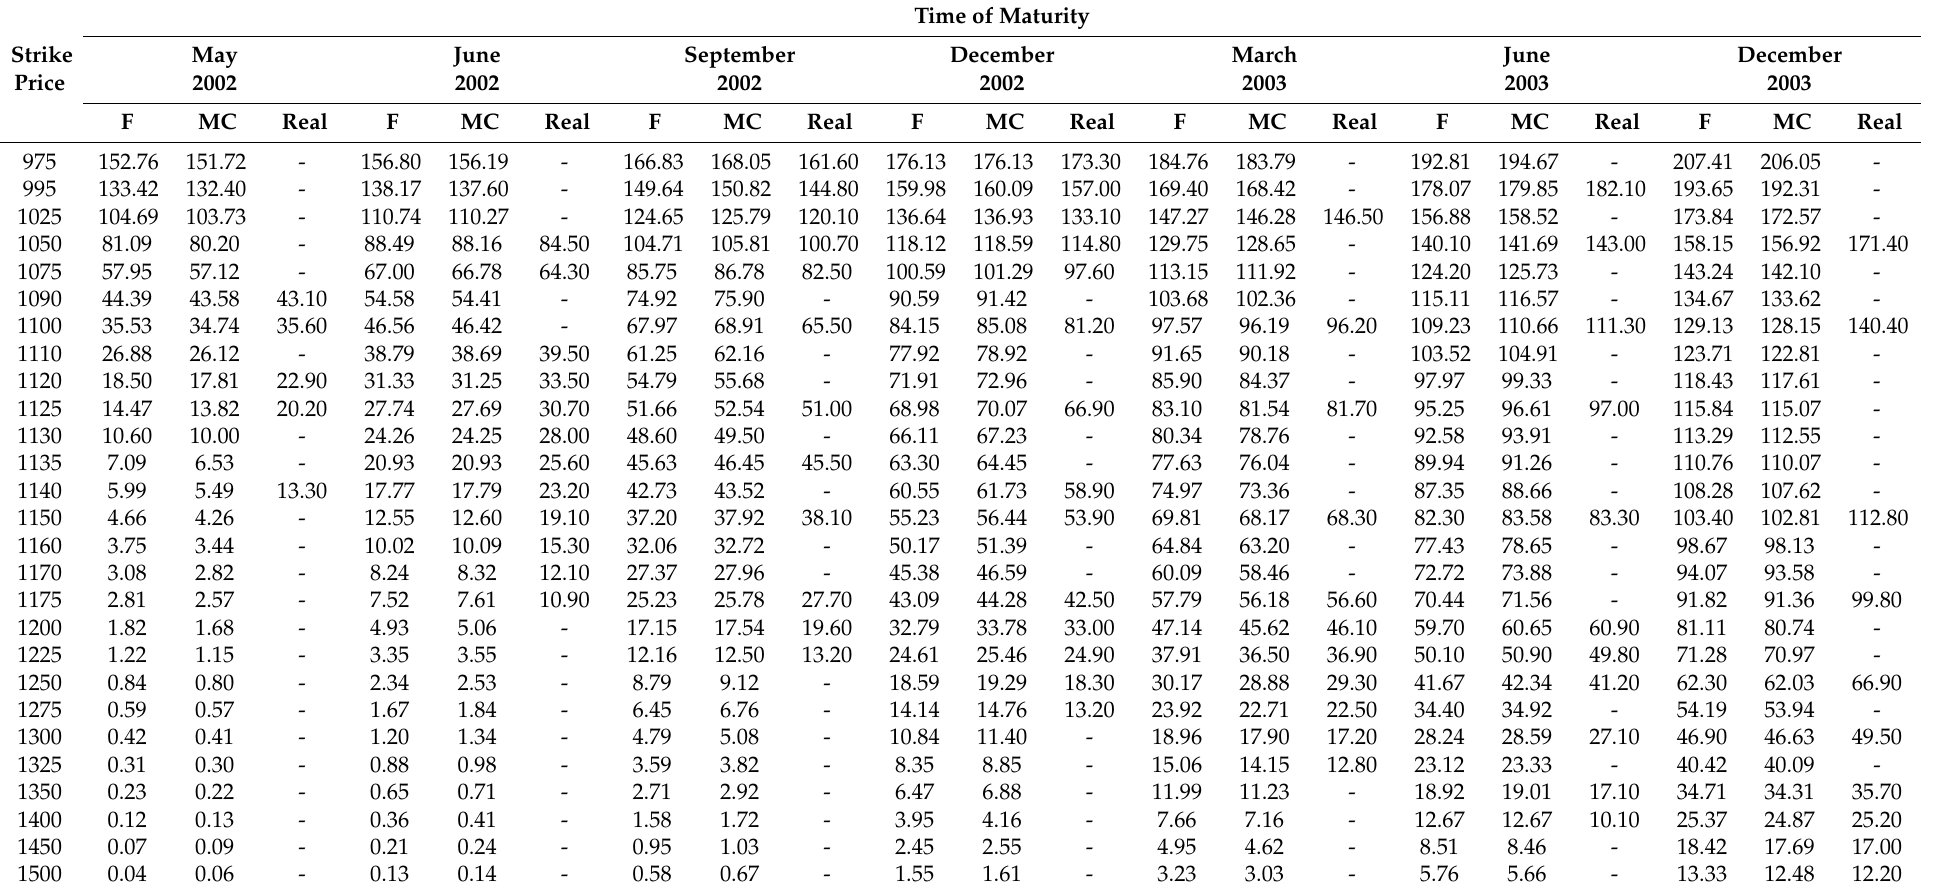
Table 1. Table containing the values for the Variance Gamma Formula (49) for n = 22, m = 27, and k = 7, denoted by "F”, the Monte Carlo method with 10000 simulated trajectories, denoted by "MC”, and the observed market values are denoted by